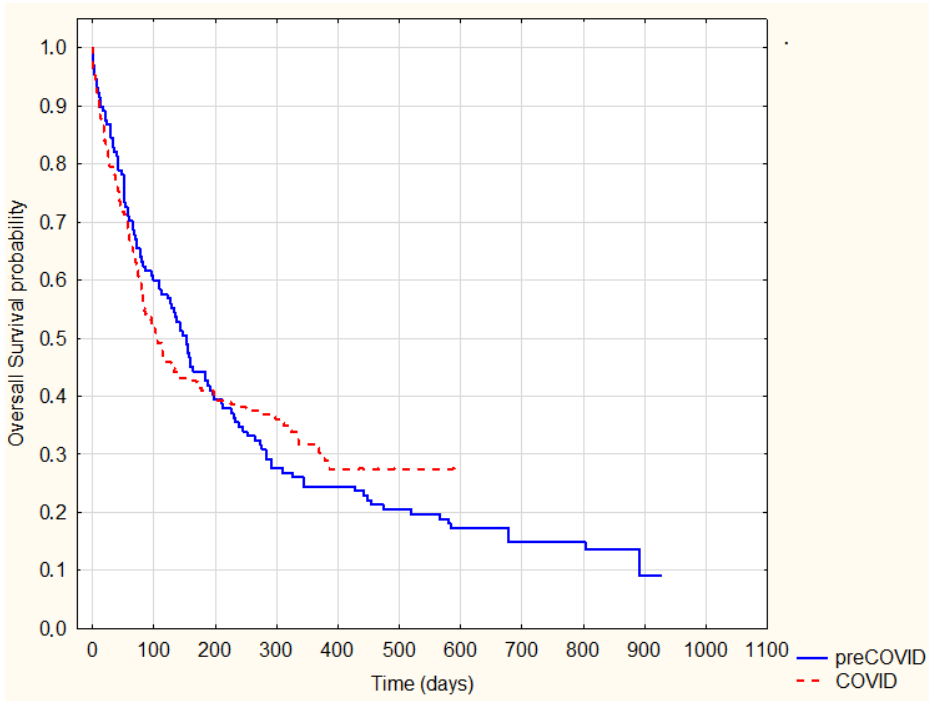
Figure 1. Kaplan–Meier Survival Analysis—pre-COVID-19 vs. COVID-19 overall survival, log-rank. P = 0.63.